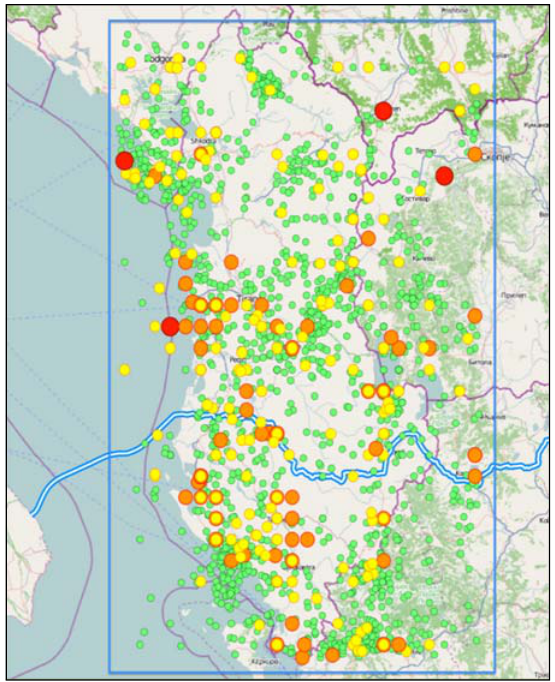
Figure 7. Seismicity for the Albanian sector of the TAP. Earthquakes with an MW 4.0–4.9 are plotted with green symbols, yellow symbols indicate events with an MW 5.0–5.9, the orange symbols MW 6.0–6.9, and the red symbols MW ≥ 7.0 [19].